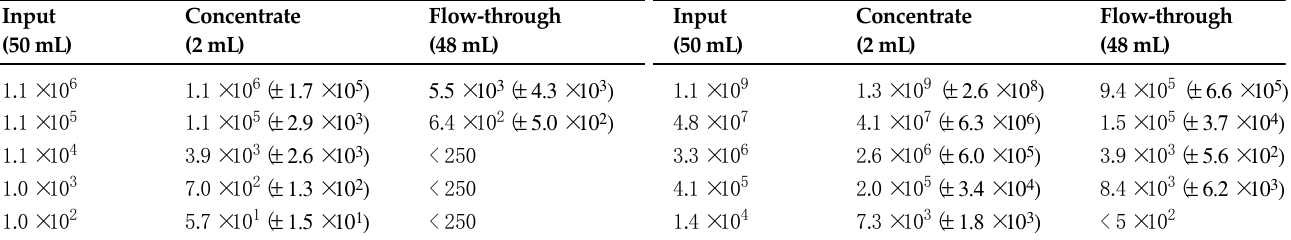
Figure 2. Viral recovery rates after concentration of MORV with Amicon ® Ultra-15 Centrifugal Filter Devices depending on the input concentrations. Different amounts of MORV virus stock ranging from 10 6 FFU to 100 FFU were diluted in 50 mL and concentrated to 2 mL using Amicon ® Ultra-15 Centrifugal Filter Devices in triplicates for each input concentration. The amounts of infectious viral particles in the input (50 mL), concentrate (2 mL), and flow-through (48 mL) were determined with IFA and used to calculate the recovery rate. Recovery rates of viral RNA were determined with MORV-specific real-time RT-PCR. The recovery rates in the concentrate for each experiment are depicted as red circles and the bars represent the mean. The amounts of infectious viral particles as well as viral RNA amount for the input, the concentrate and the flow-through are shown in the table. Values are given as mean with standard deviation.